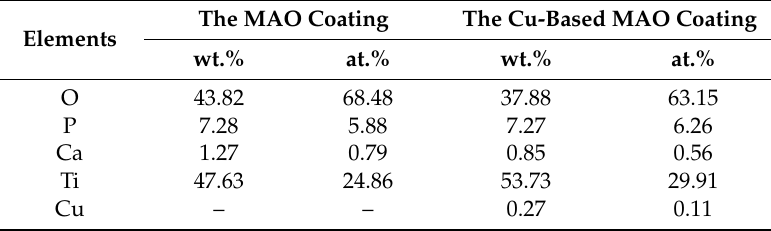
Figure 4. Surface morphologies of the coatings at post-immersion in SBF at 36.5 ◦ C for 28 days: ( a ) 500 × and ( b ) 20000 × for the MAO surface and ( c ) 500 × and ( d ) 20000 × for the Cu-based MAO surface. Table 4. EDS area spectra results of the MAO and the Cu-based MAO coatings at post-immersion in SBF.